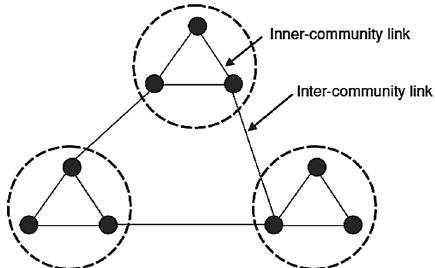
Figure 4. Initial network with M = 3 and m 0 = 3